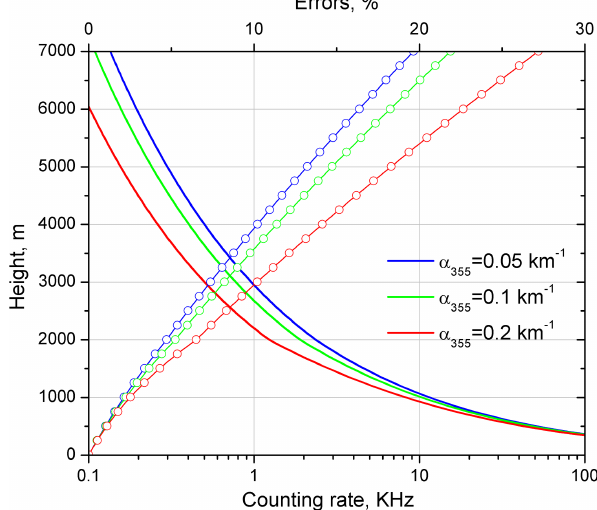
Figure 2. Modeled photon-counting rate (lines) and statistical un- certainties of the methane mixing ratio measurements (lines and symbols) for a 2ppm methane concentration and three values of aerosol extinction coefficient α 355 = 0 . 05, 0.1, 0.2km − 1 . Aerosol extends from z = 0 to z = 2000m. Signal-averaging time is